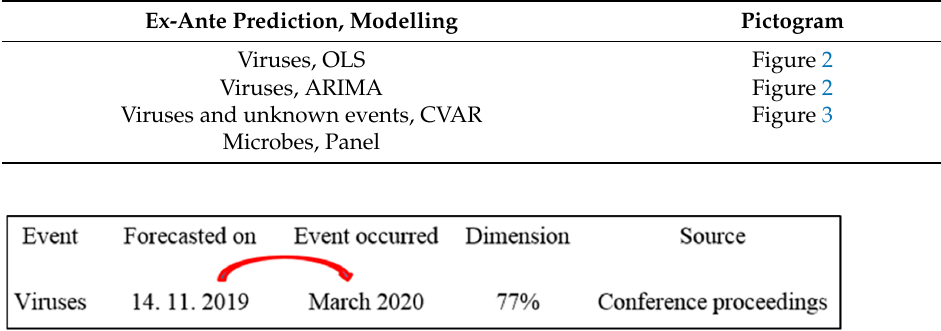
Table 1. The review of forecasting.